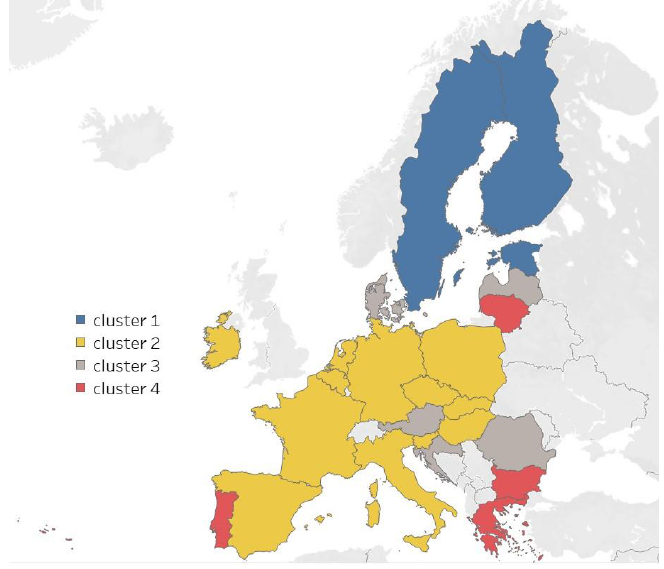
Figure 2. Choropleth map for “smart and efficient energy systems”. Source: Authors’ study based on [75].